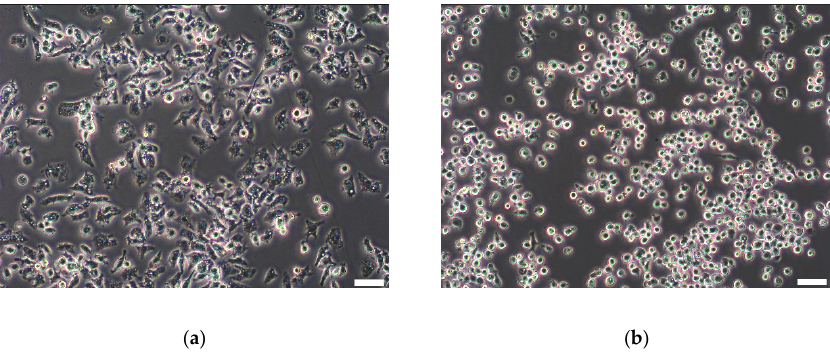
Figure 2. Representative light microscopy images of J774A.1 macrophages. ( a ) Macrophages 24 h